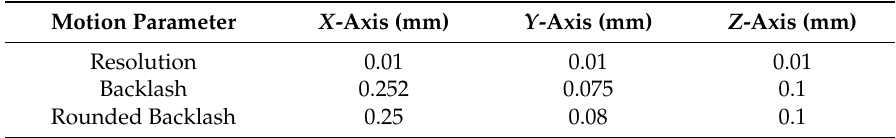
Table 1. Motion specifications for the circuit mill.